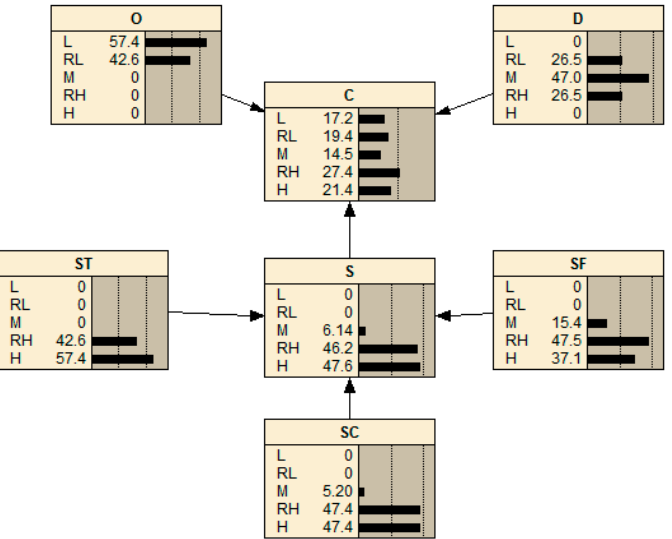
Figure 6. Results of risk assessment of FM1 using Netica software.